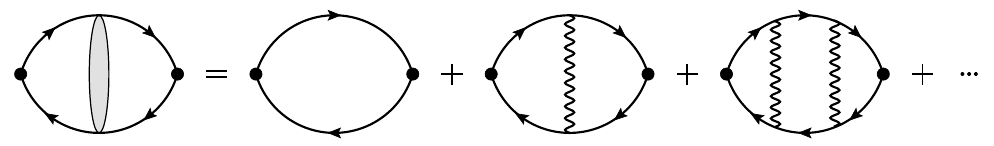
Figure 17 . Diagrams for the creation of w + w (cid:0) at a point. The ladder diagrams from the exchange of Coulomb photons must be summed to all orders.